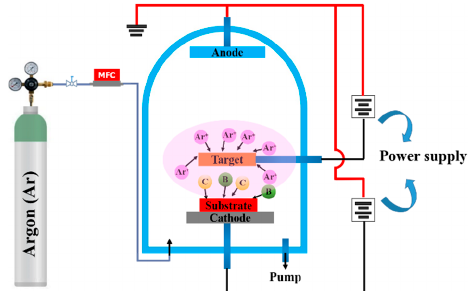
Figure 1. Schematic of the double glow plasma surface metallurgy technique.